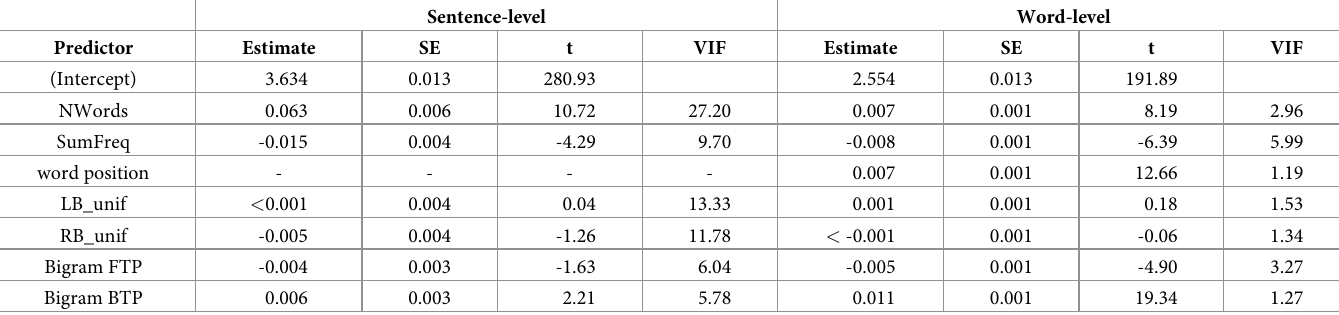
Table 8. Results of the ‘full’ model at the sentence-level and word-level.